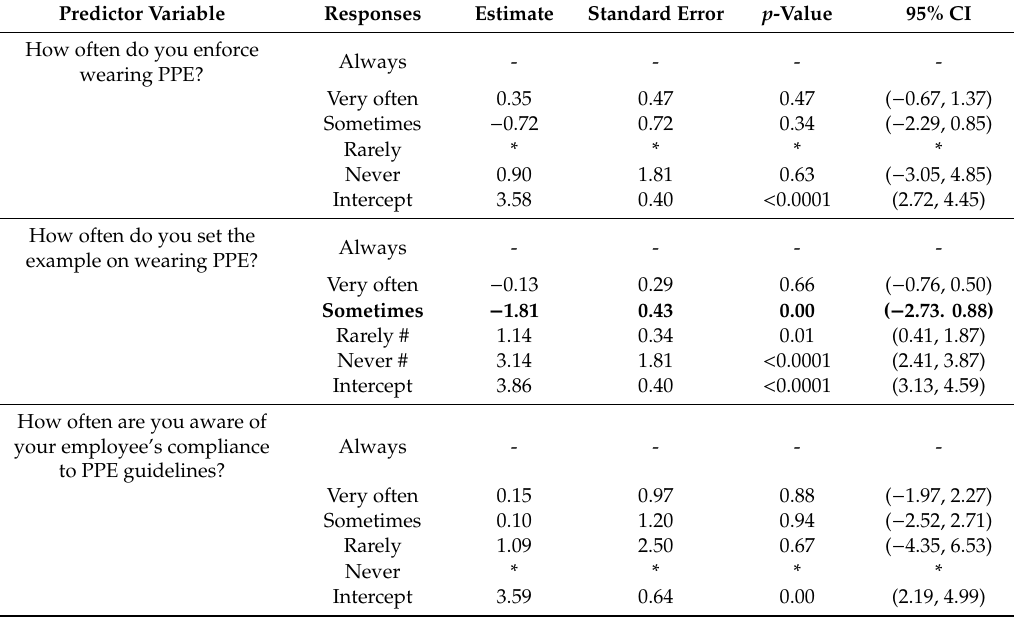
Table 6. Univariate linear regression model of managers’ and supervisors’ beliefs, attitudes, and practices on PPE compliance to determine which variables will increase PPE compliance among wastewater